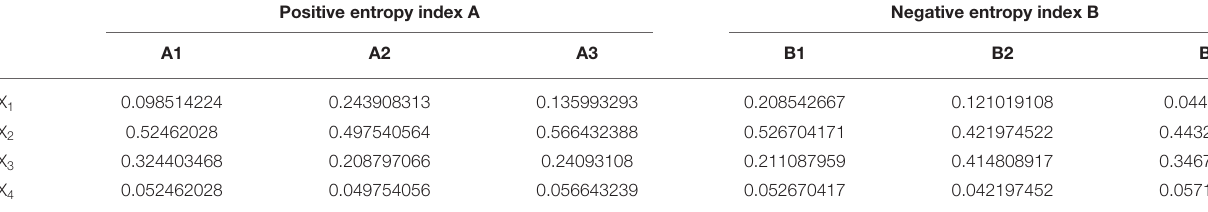
TABLE 4 | P matrix.